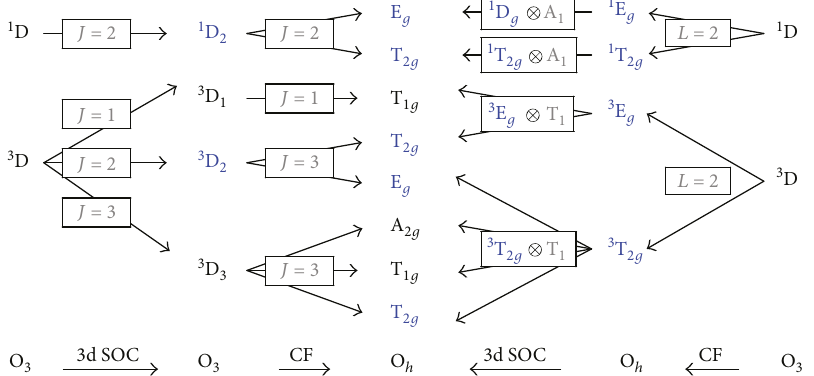
Figure 12: Branching of the intermediate state terms 1 D and 3 D of Ti 4+ (3d 0 ) due to 3d SOC and an O quadrupole 1s XAS step (GS → IS) are shown in blue.